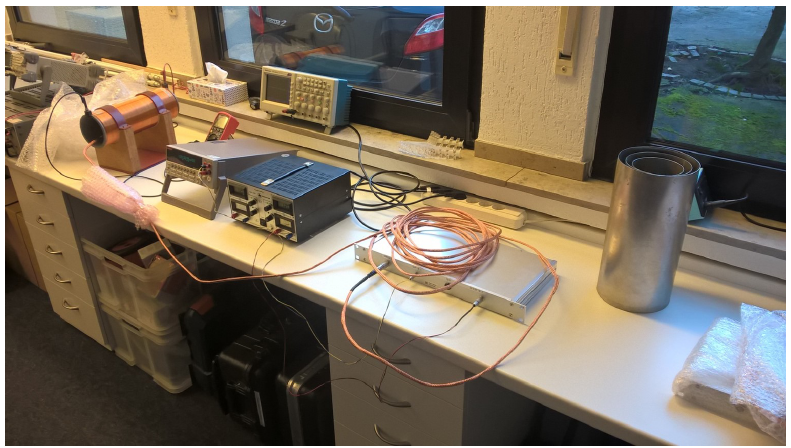
Figure 9. Acceptance test setup, the solenoid is visible on the left, the zero-gauss chamber is visible on the